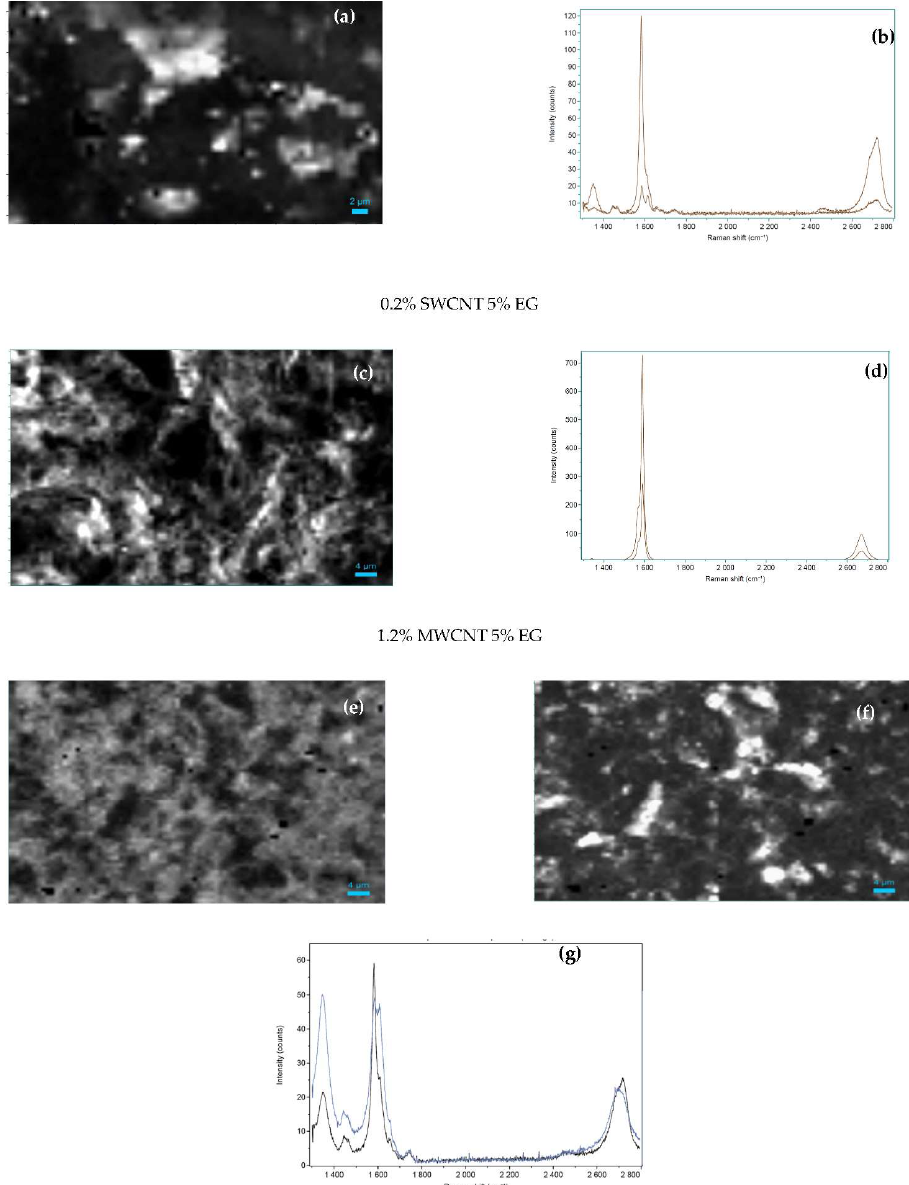
Figure 6. Images of Raman intensity maps and typical Raman spectra: ( a ) G band intensity distribution of the composite with 5 wt.% of EG (higher intensity areas in white); ( b ) Raman spectra of the regions presenting higher and lower intensity; ( c ) G band intensity distribution for the composite with 0.2 wt.% single wall carbon nanotubes (SWCNT) and 5 wt.% of EG (higher intensity in white—higher SWCNT concentration); ( d ) Raman spectra corresponding to the regions of higher and lower intensities of the G band of 0.2 wt.% SWCNT and 5 wt.% of EG; ( e ) D band intensity distribution of the composite with 1.2 wt.% of MWCNT and 5 wt.% EG (darker areas corresponding to EG); ( f ) G to D intensity ratio distribution where regions of higher intensity ratio appear in white (EG) and lower intensity ratio in black (MWCNT); ( g ) Raman spectra corresponding to the regions of higher and lower intensity